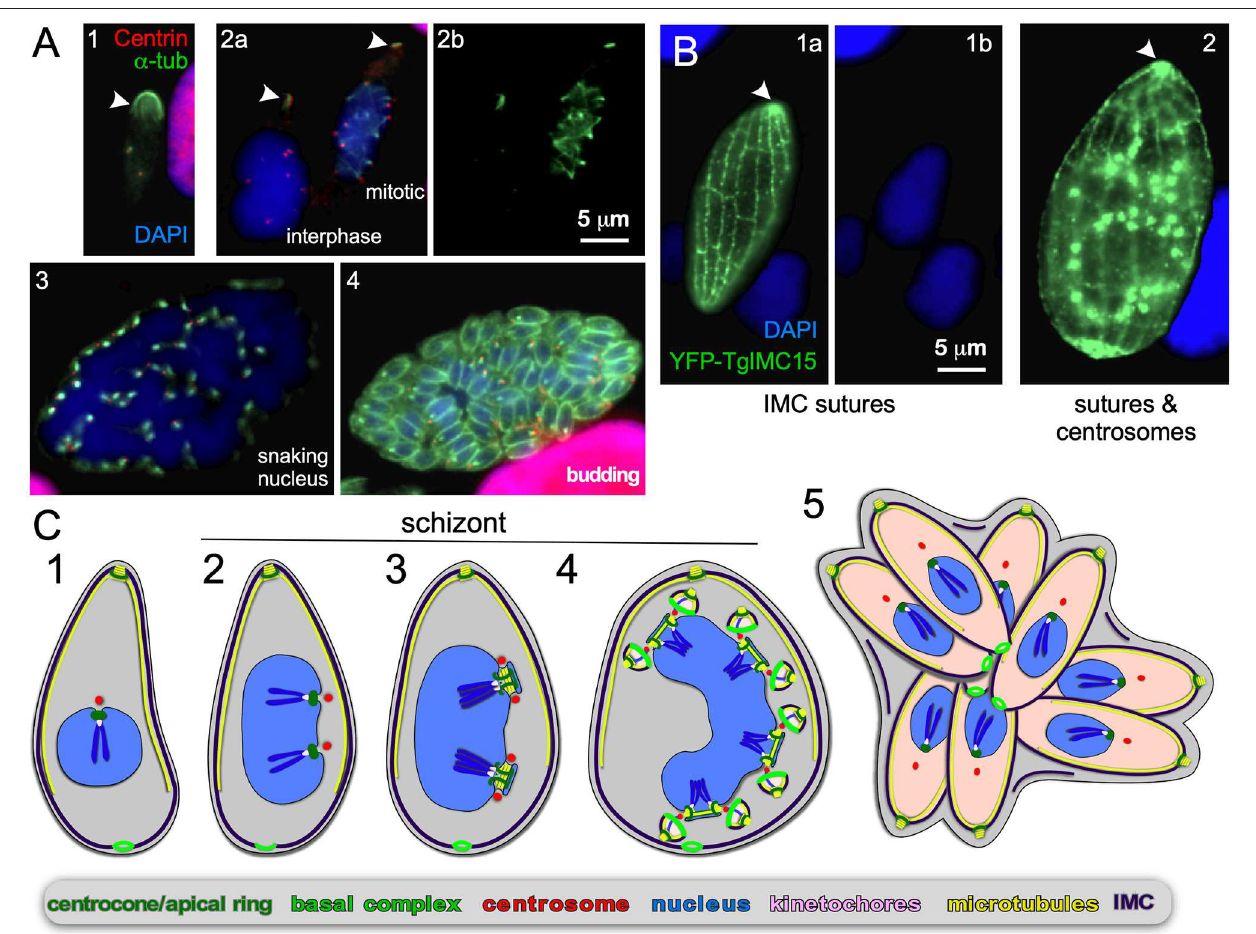
FIGURE 6 | Endopolygeny without nuclear fission by Sarcocystis neurona in the intermediate host. (A) Staining of progressive cell division cycle stages (1–4) with α -tubulin (green) marking the subpellicular microtubules of the mother cytoskeleton (arrow heads), the mitotic spindles (2b, right parasite; 3) and daughter merozoites subpellicular microtubules (4). Centrin staining (red) marks the centrosomes, which due to z-stack selection are not visible for all spindles/parasites. Scale bar applies across panels. (B) Overexpression of a Toxoplasma YFP-IMC15 fusion protein (green) highlights the mother cell’s cortical IMC sutures in both panels, whereas in further progressed panel 2 the bright internal spots mark the centrosomes poised for budding. Arrowhead marks the apical end of the mother parasite. (B) Modified from Dubey et al. (2017). Scale bar applies across panels. (C) Schematic of apicomplexan asexual cell division by endopolygeny without karyokinesis. Note the polyploid nuclei undergoing synchronized cycles of M-phase and mitosis resulting in geometrically expanded daughter cell numbers. Also note that the mother’s cytoskeleton is maintained throughout the schizont stages (2–4) and is only destabilized just before emergence of nearly mature daughters